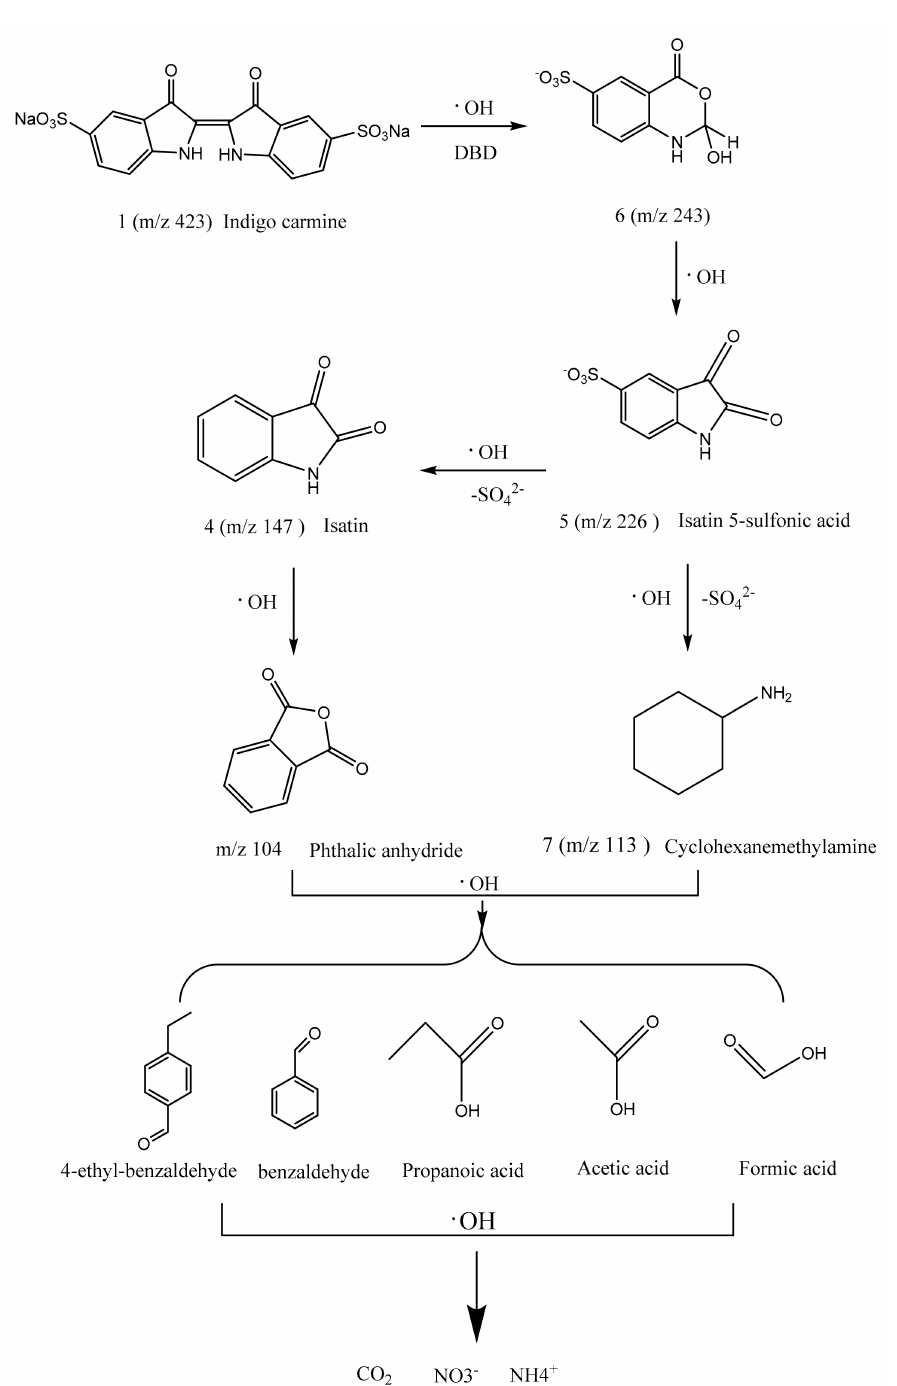
Figure 1. Degradation pathway of indigo carmine in an integrated resin adsorption/DBD